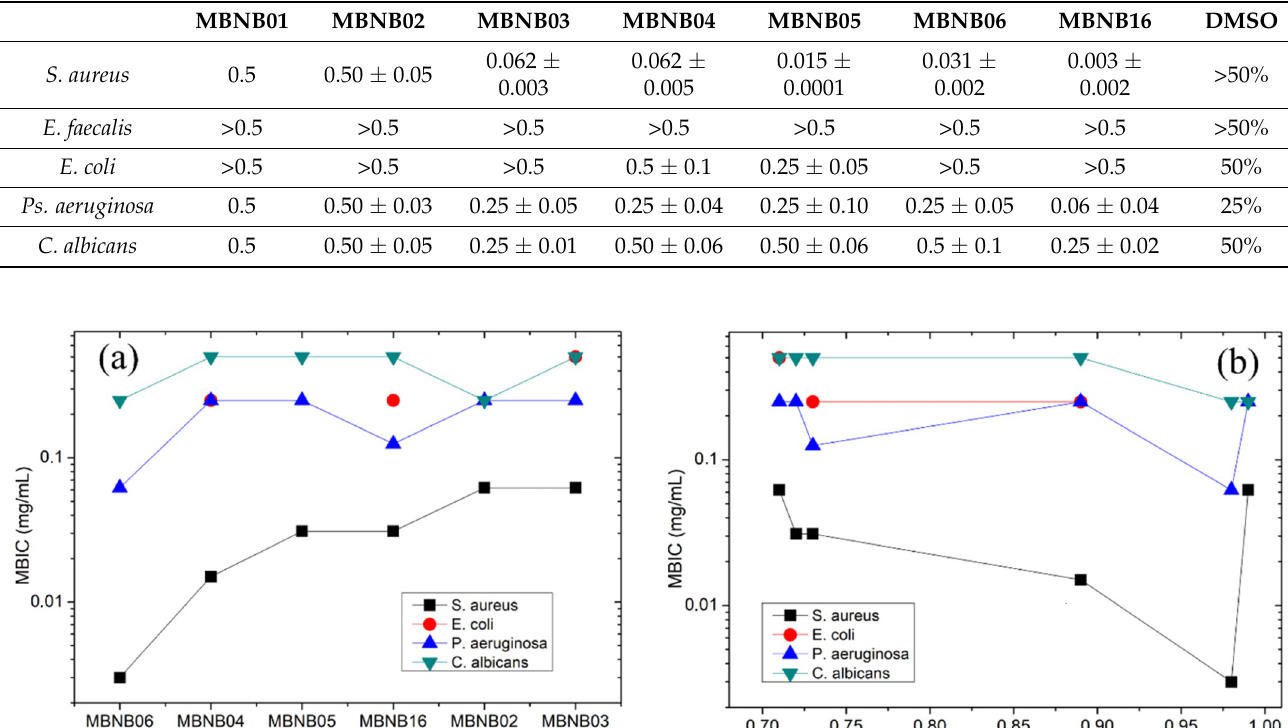
Table 4. Comparative average MIC and MBIC values in mg/mL for the different powders. For each powder, the values are averaged over all of the five tested microbial strains. Data are reported as mean ± SD.